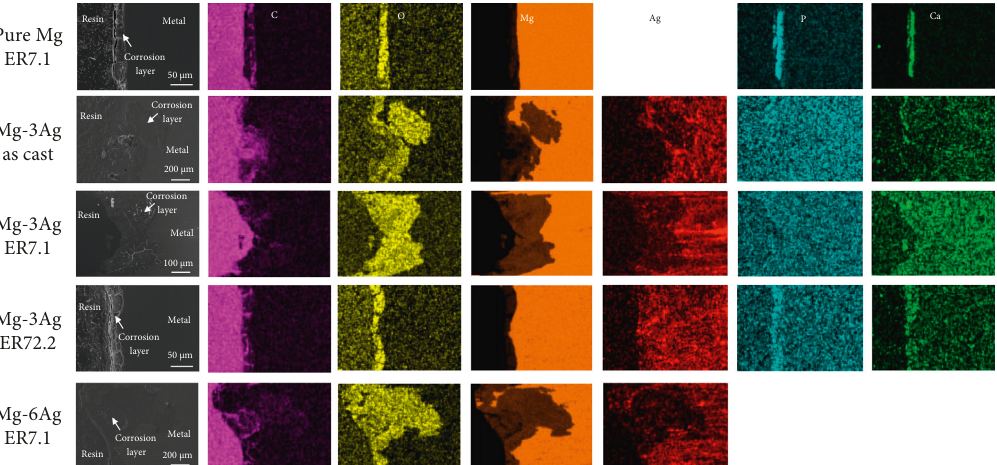
Figure 10: BSE images and chemical element mappings of the cross section of samples after an immersion test for 16